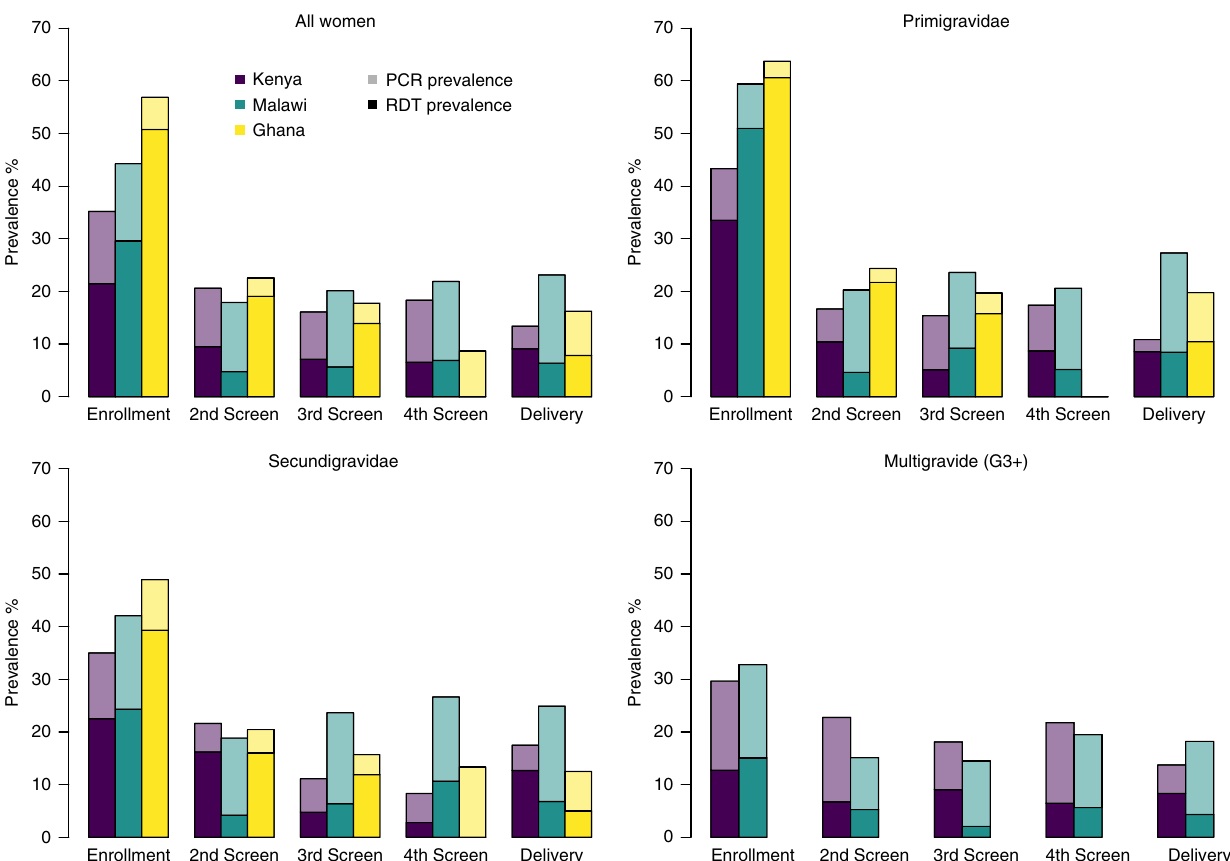
Fig. 1 Prevalence by and RDT and PCR during ISTp. Figure shows prevalence of RDT-positive infection, con fi rmed by PCR (height of darker bars) and the additional prevalence of RDT negative, PCR positive infection prevalence (height of lighter bars) at each ANC visit at which RDT testing was carried out during ISTp from enrolment to delivery by trial